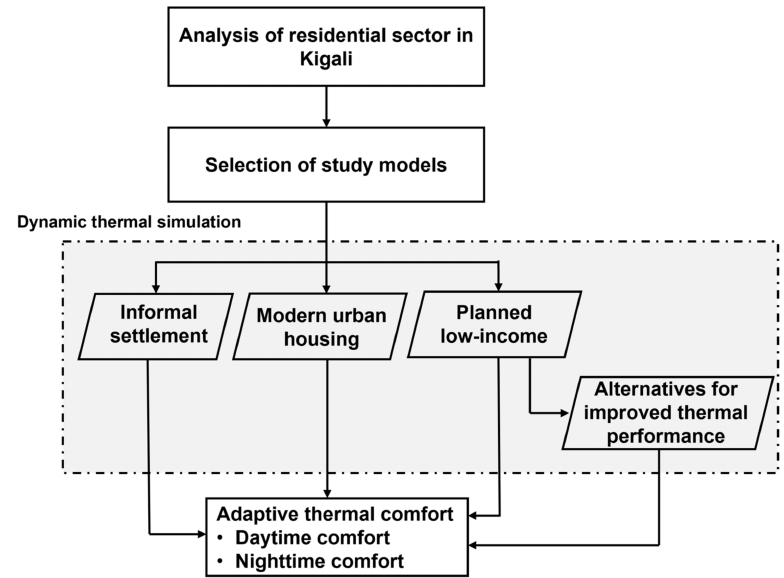
Figure 1. Flowchart of the study